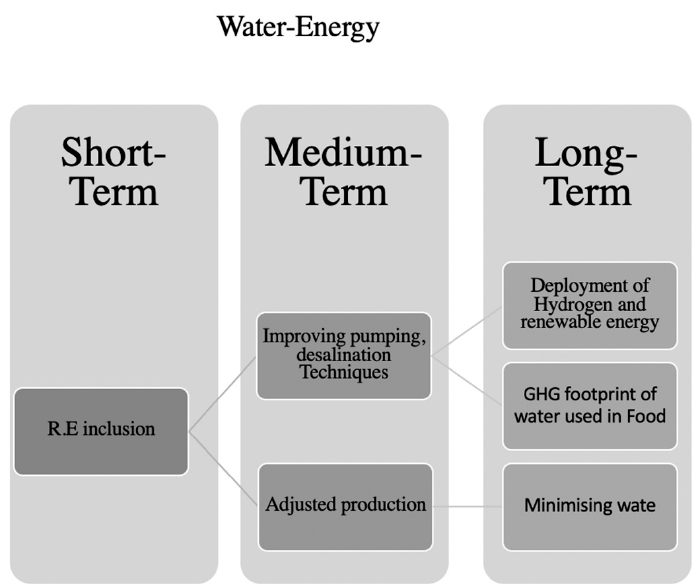
Figure 6. Sustainable environment approach for WEF systems management.